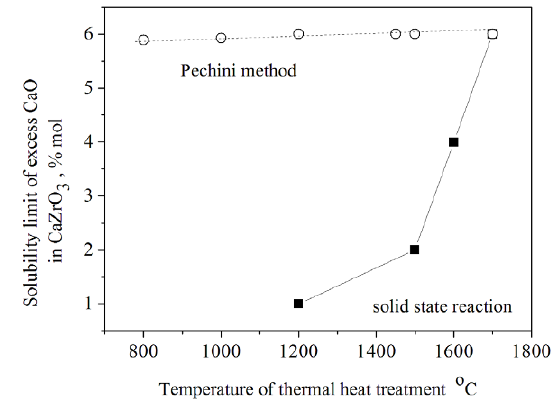
Figure 6. TEM microphotograph of non-stoichiometric CaZrO (51.5% mol CaO) grain boundary structure.